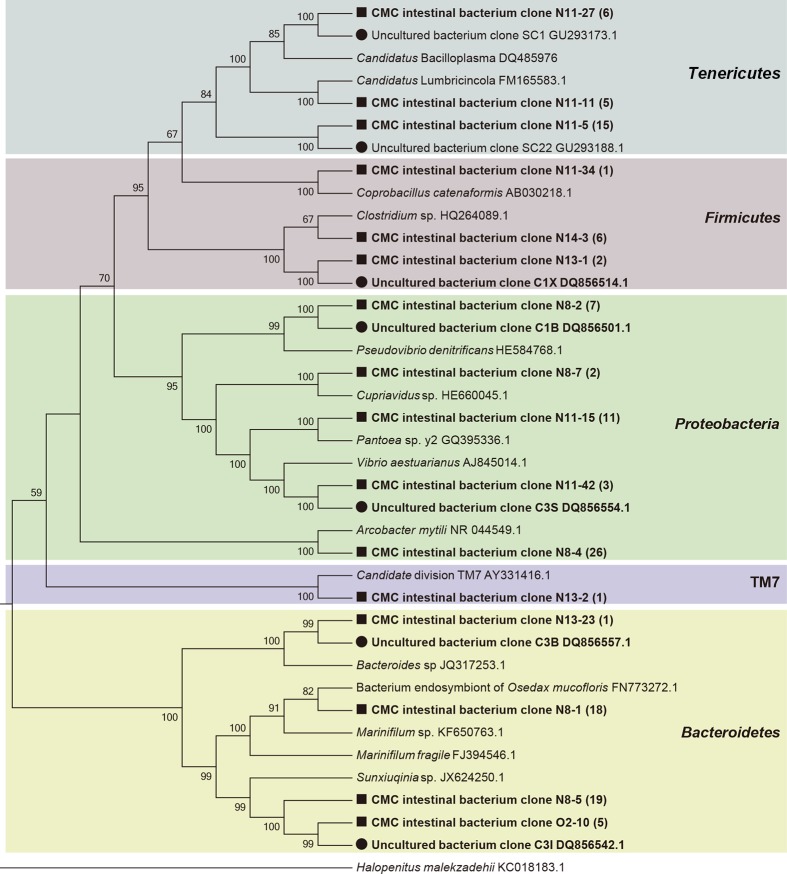
Phylogenetic affiliations of the bacterial 16S rRNA genes cloned from crab intestines.The clones obtained from crab intestines are shown in bold. The clones obtained in this study and those from a previous study (Li et al, 2007) are indicated with black square and black dot, respectively. The number of clones is shown in parenthesis. The background colors indicate the bacterial phylotypes of different phyla.